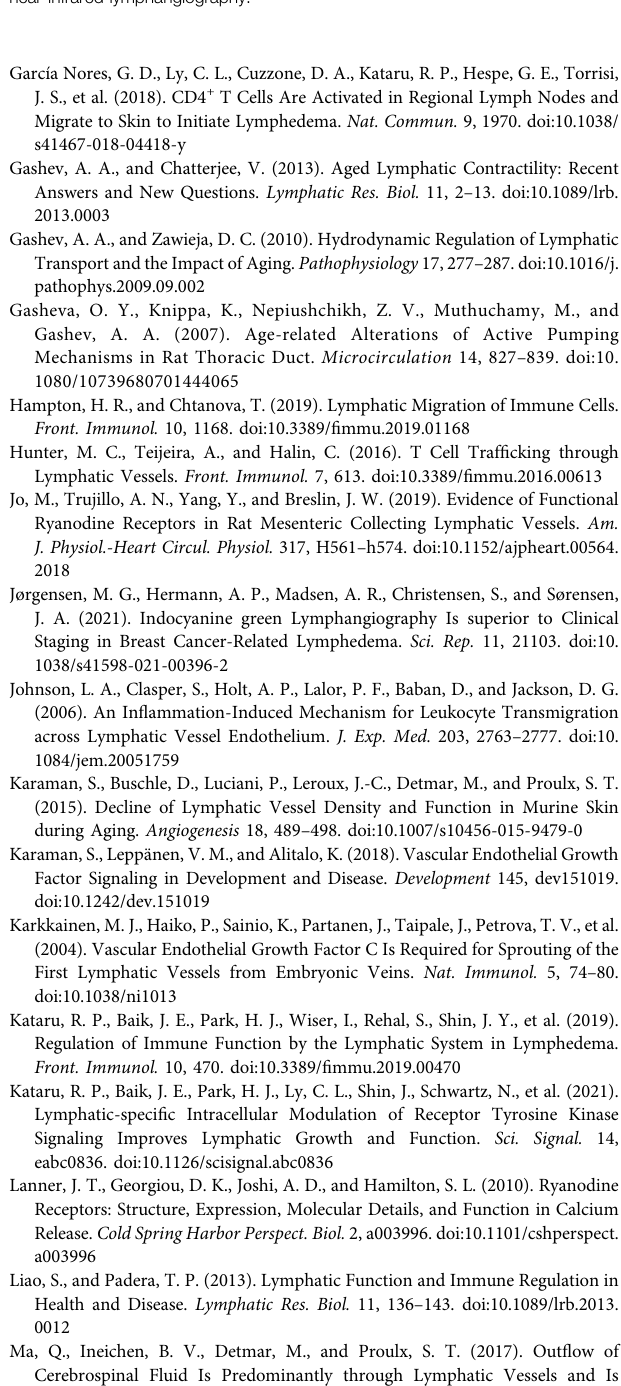
lymphatic vessels (LYVE-1) and IgG. (B) Quanti fi cation of antibody deposits within 100 µm radius of lymphatic vessels as a percentage of lymphatic vessel area. All quanti fi cations are mean ± SD, unpaired Student ’ s t